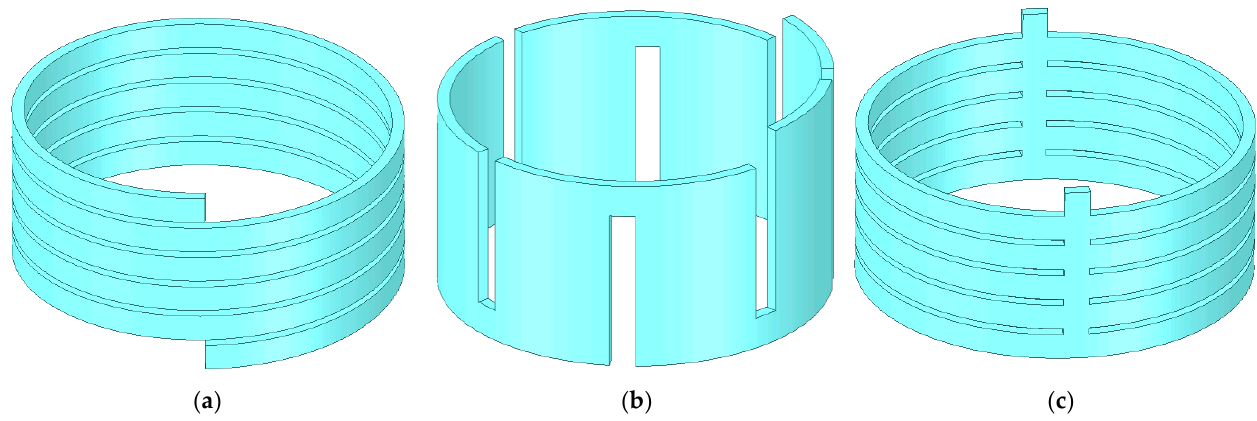
Figure 9. Different types of housing cooling structures. ( a ) Spiral channel. ( b ) Axial channel. ( c ) Parallel channel.